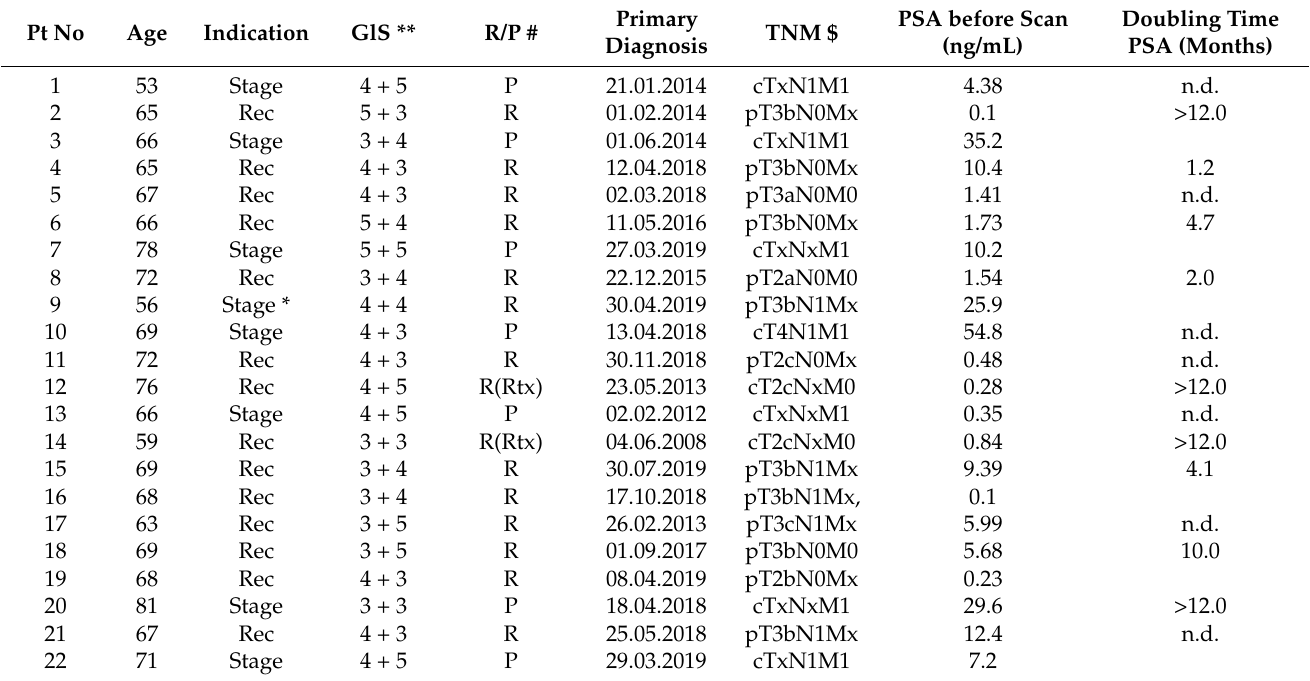
Table A1. Demographic and clinical data of all patients included into the study including Gleason score, radical or palliative initial therapy, pathological or clinical diagnosis, TNM classification PSA level before PSMA